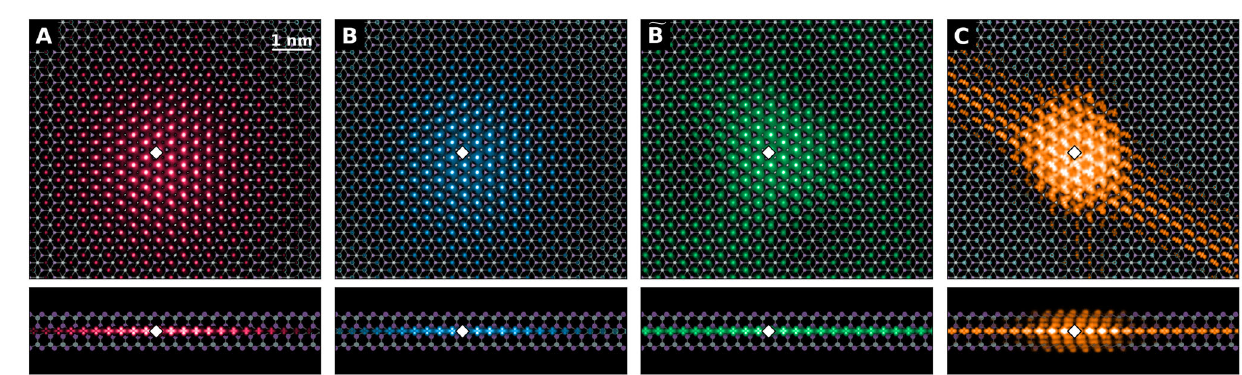
Fig. 7 Wavefunctions. Top (upper panels) and side (lower panels) views of the square moduli of the wavefunctions of excitons A, B, e B , and C in MoSi 2 P 4 . The white diamond marks the highest probability density of the